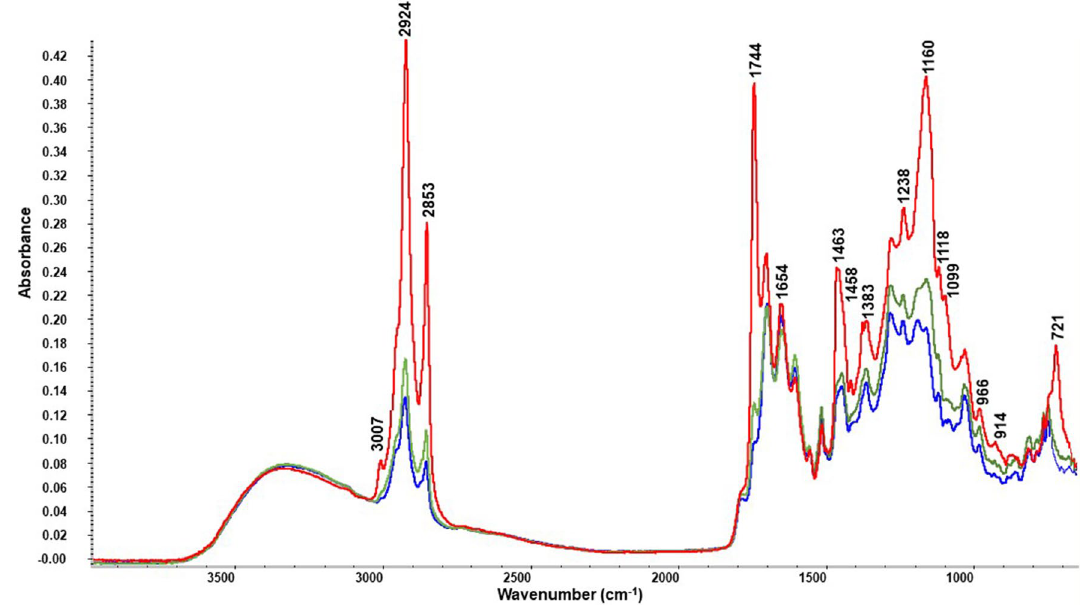
Figure 1. Comparison of FTIR spectra: Cold Brew (blue line), Hot Brew (green line) and Hardtank (red line) for the exemplary Brazil natural (Bn) coffee sample. [mg/g] Gw Sw